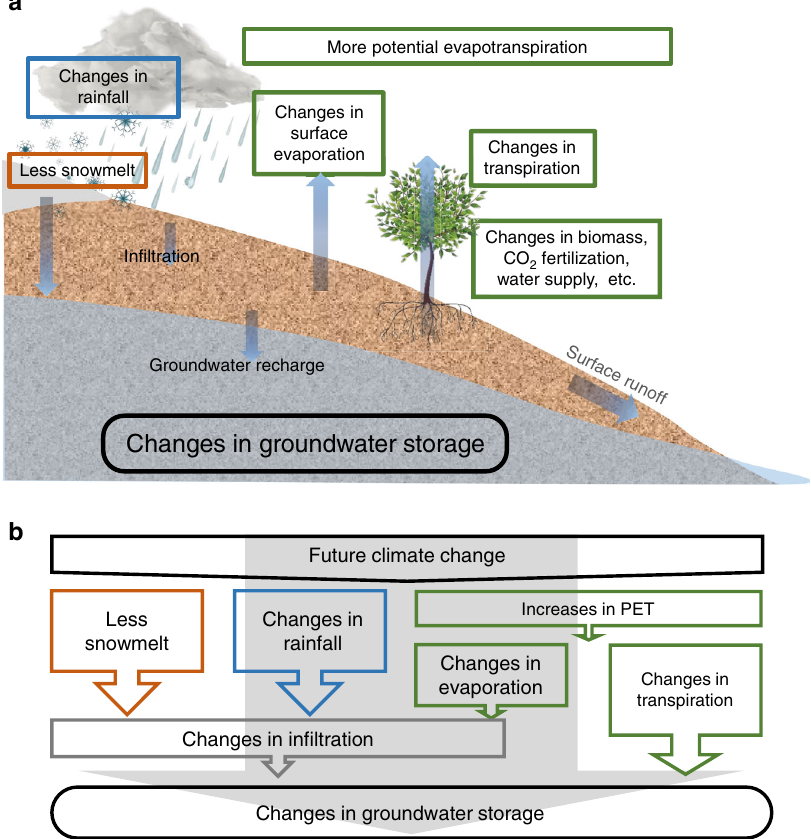
Fig. 1 Groundwater and climate change. a Schematic of land hydrological processes. See Supplementary Fig. 20 for each aquifer. b Controlling factors affecting divergent groundwater responses. This fi gure has been designed using resources from www.Freepik.com.